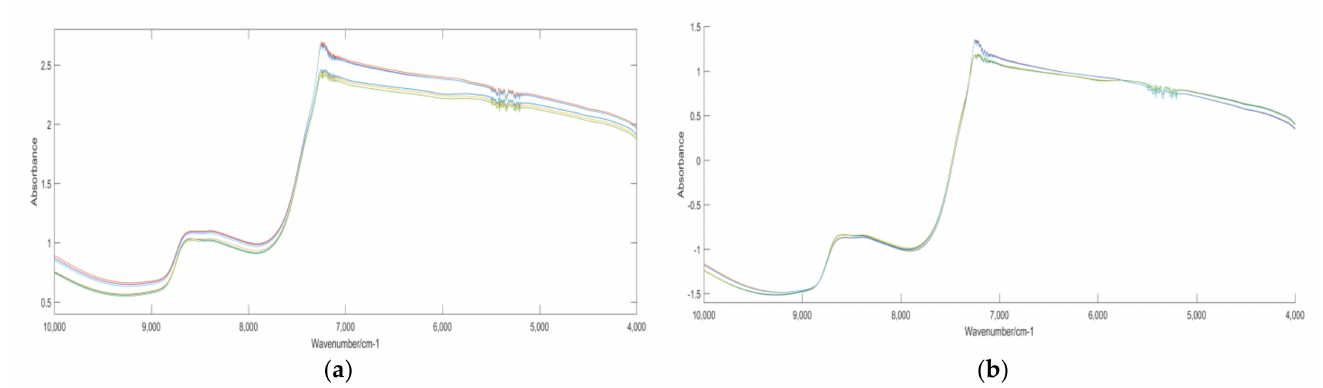
Figure 2. Original spectra and pretreated spectra: ( a ) Original mean NIR spectra of Chunmee tea; ( b ) the mean spectra after SNV